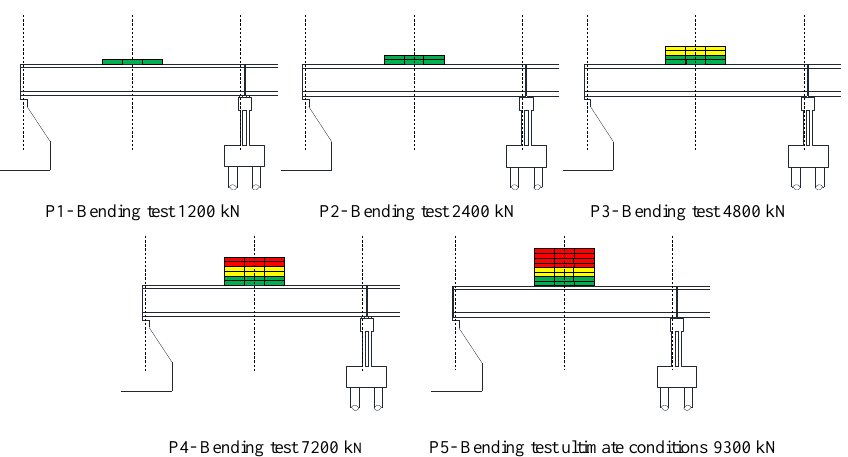
Figure 7. Load-test protocol: five loading phases with an increasing number of ballast weights.